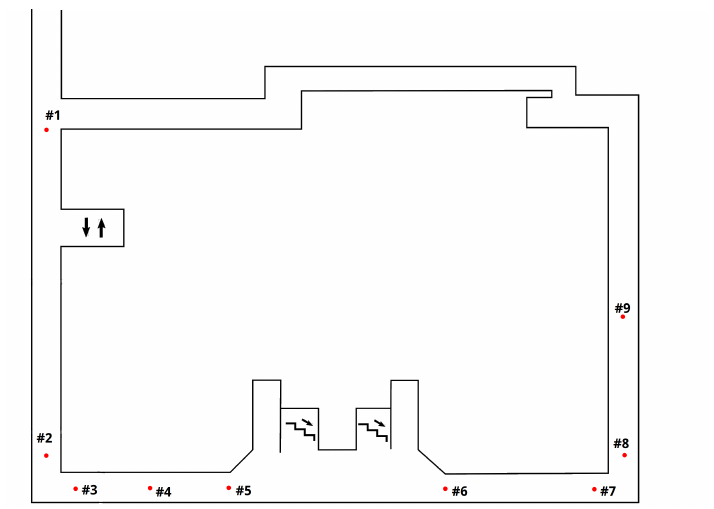
Figure 5. Checkpoint positions in the first scenario. The route starts on #1 and ends on the marker #9 consisting of more than a hundred steps on average. Every subject traveled 85 m along the markers in the ascending